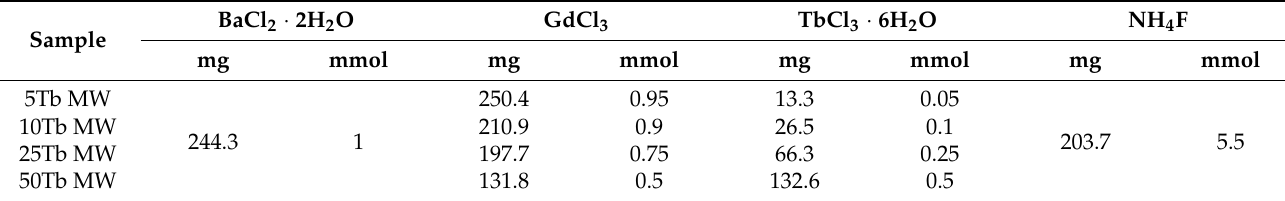
Table 1. Amount of precursors used in the synthesis process.